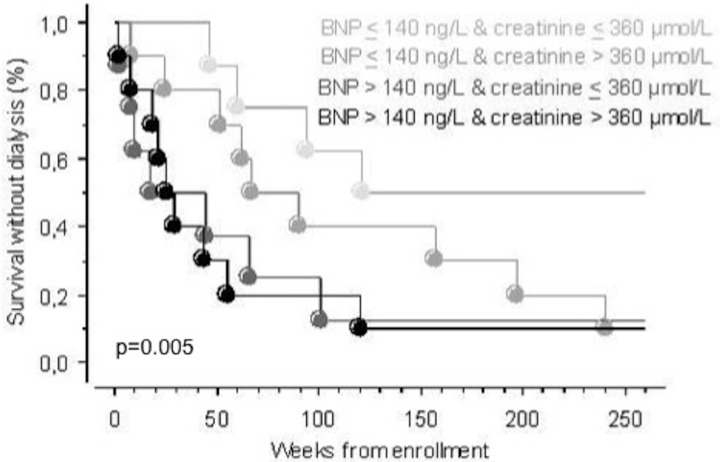
Kaplan Meier curves for survival without dialysis.The population is stratified according to BNP concentration above and below cut-off, as well as creatinine above and below the median, after 5 years follow-up. The significance indicated represents overall comparison.